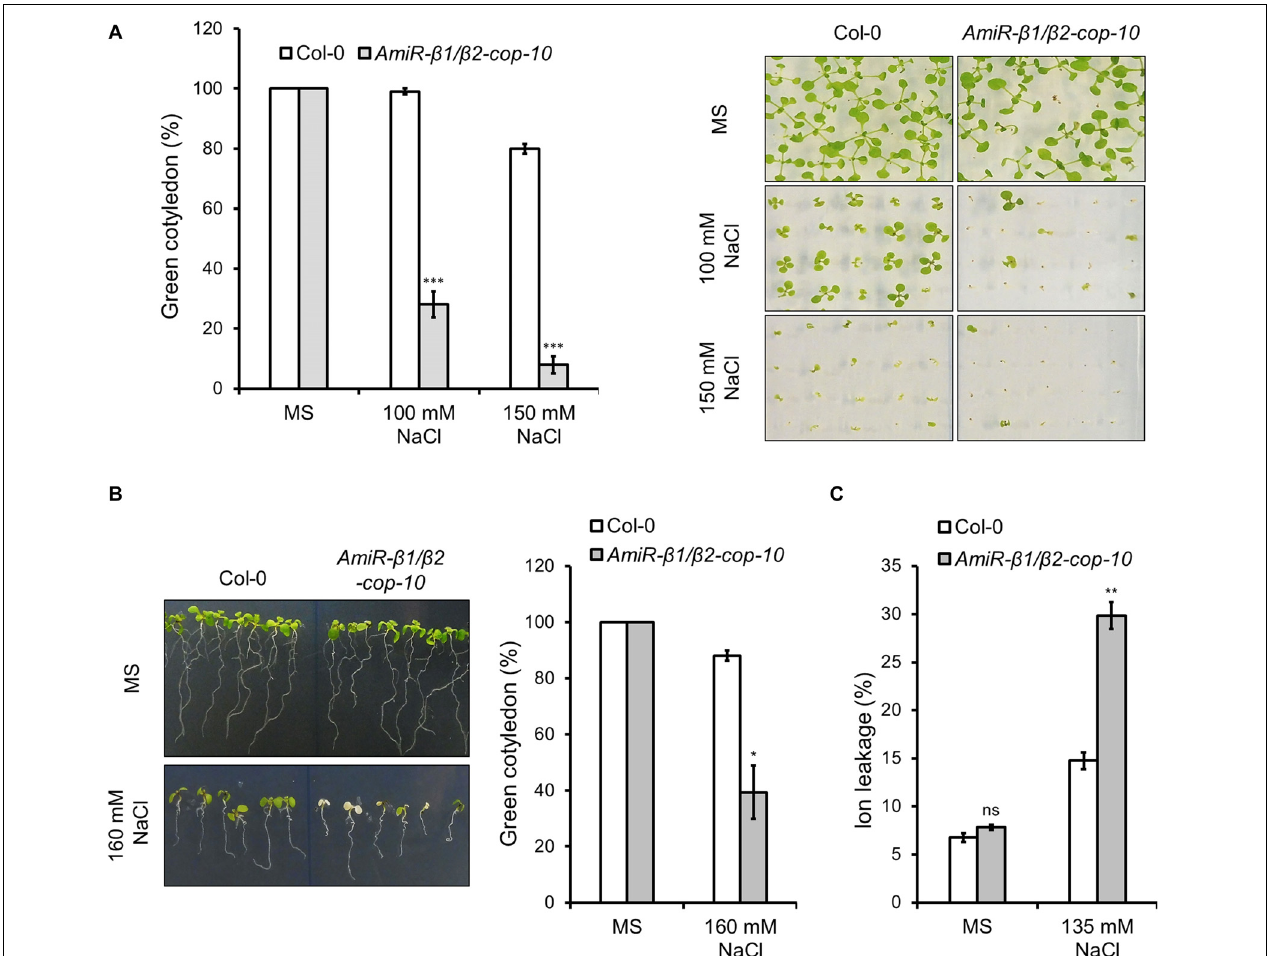
FIGURE 5 | Phenotypic analysis of amiR- β 1/ β 2-cop exposed to salt (NaCl). (A) Wild type (Col-0) and amiR- β 1/ β 2-cop seeds were sown on 0.5 × MS for control conditions and 0.5 × MS supplemented with 100 mM NaCl and 150 mM NaCl in Petri plates. The percentage of seedlings with green cotyledons was calculated after 12 days. Data are mean ± s.e.m. ( n = 100) of four independent experiments. (B) Seeds of wild type (Col-0) and the amiR- β 1/ β 2-cop mutant were sown on MS plates without salt and grown for 4 days before being transferred to MS plates containing 160 mM NaCl. Three days after transplantation, the percentage of seedlings with green cotyledons was calculated and expressed as mean ± s.e.m. ( n = 60) of three independent experiments (right panel). An image of a representative experiment is shown in the left panel. (C) Ion leakage of wild type and the amiR- β 1/ β 2-cop mutant 1 day after transplanting seedlings to MS plates containing 135 mM NaCl. Data show mean ± s.e.m of three independent experiments. Statistical significance: ns, not significant; * p < 0.05; ** p < 0.01; *** p < 0.001.